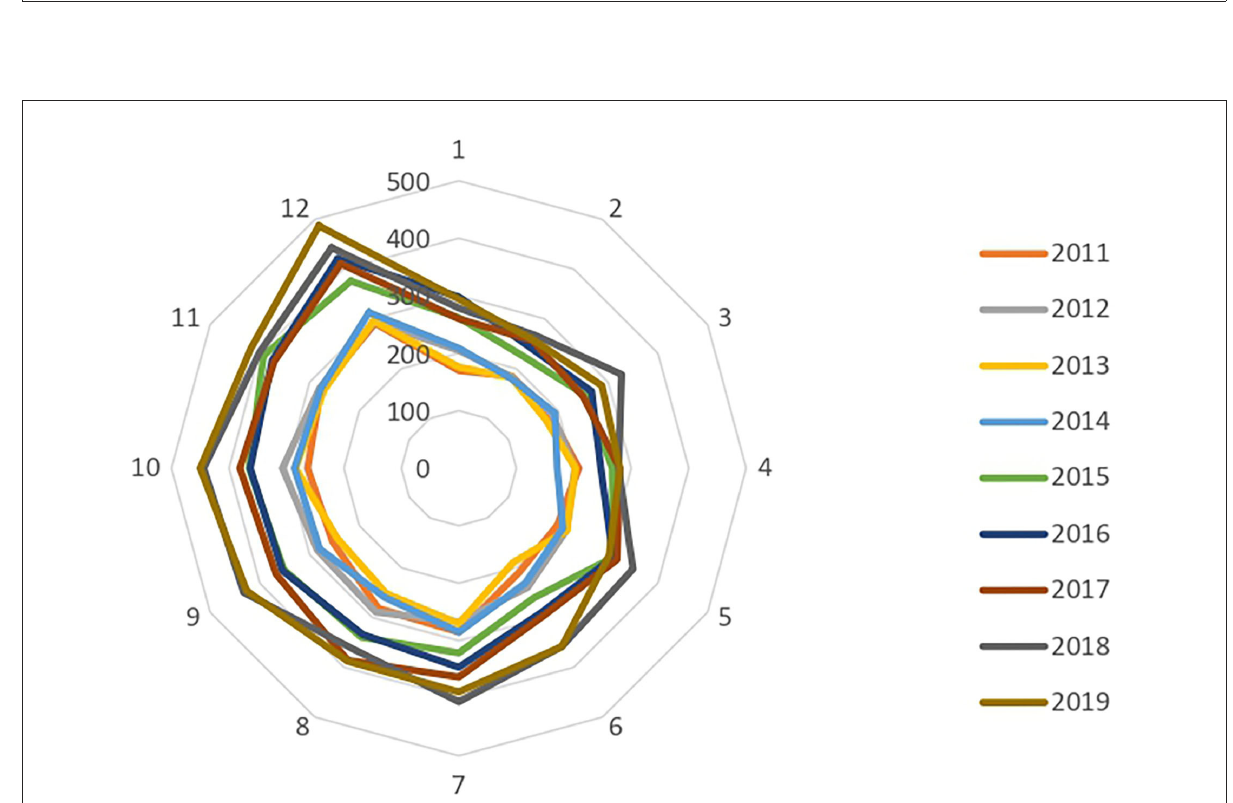
FIGURE4 Birth months of children with ADHD at initial inpatient diagnosis between 2011 and